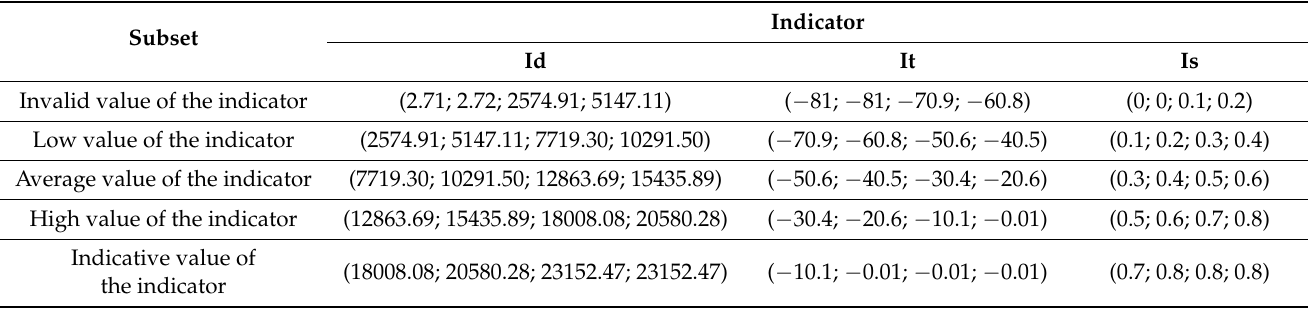
Table 1. T-numbers {y} for the values of a linguistic